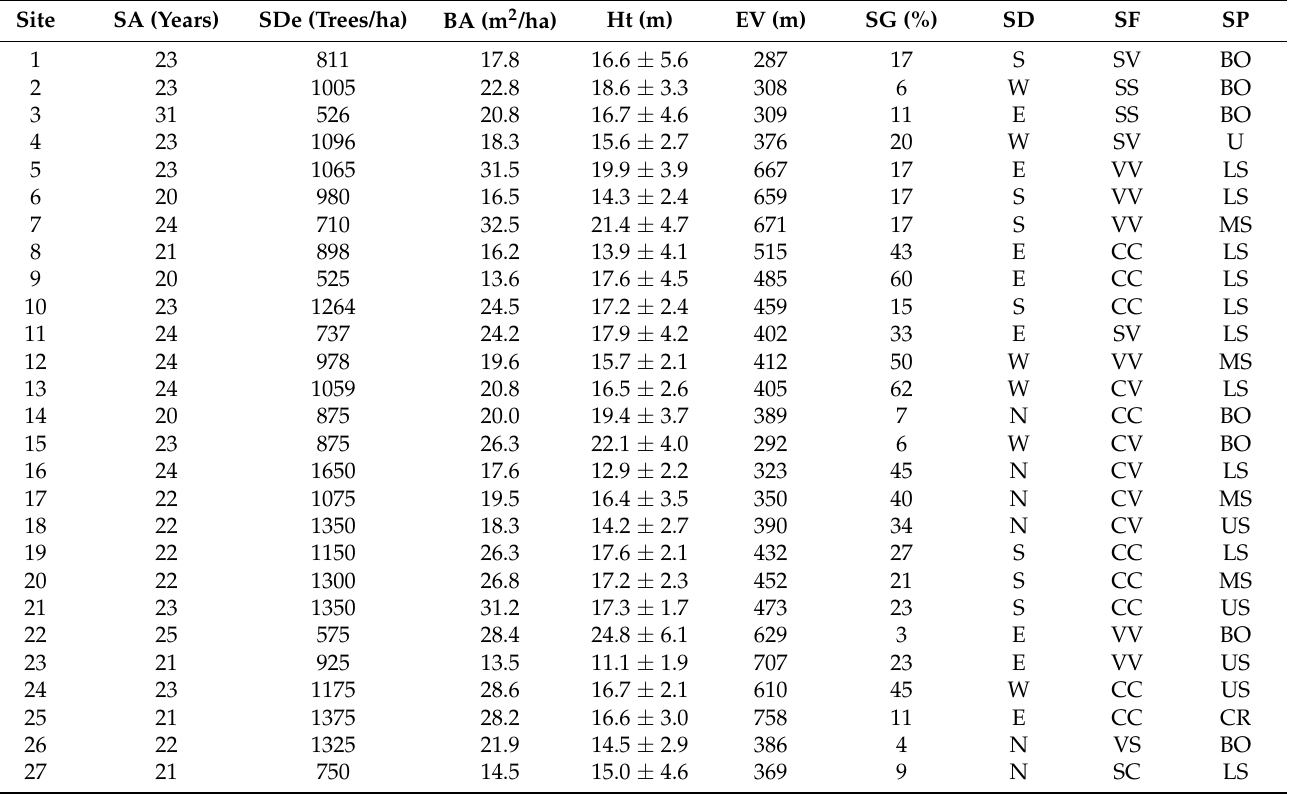
Table A1. Stand and topographic conditions of selected teak plantations. Stand age (SA); stand density (SDe); basal area (BA); total height (Ht); elevation (EV); slope gradient (SG); slope direction (SD), north (N), east (E), south (S), west (W); slope form (SF), straight (S), convex (V), concave (C);